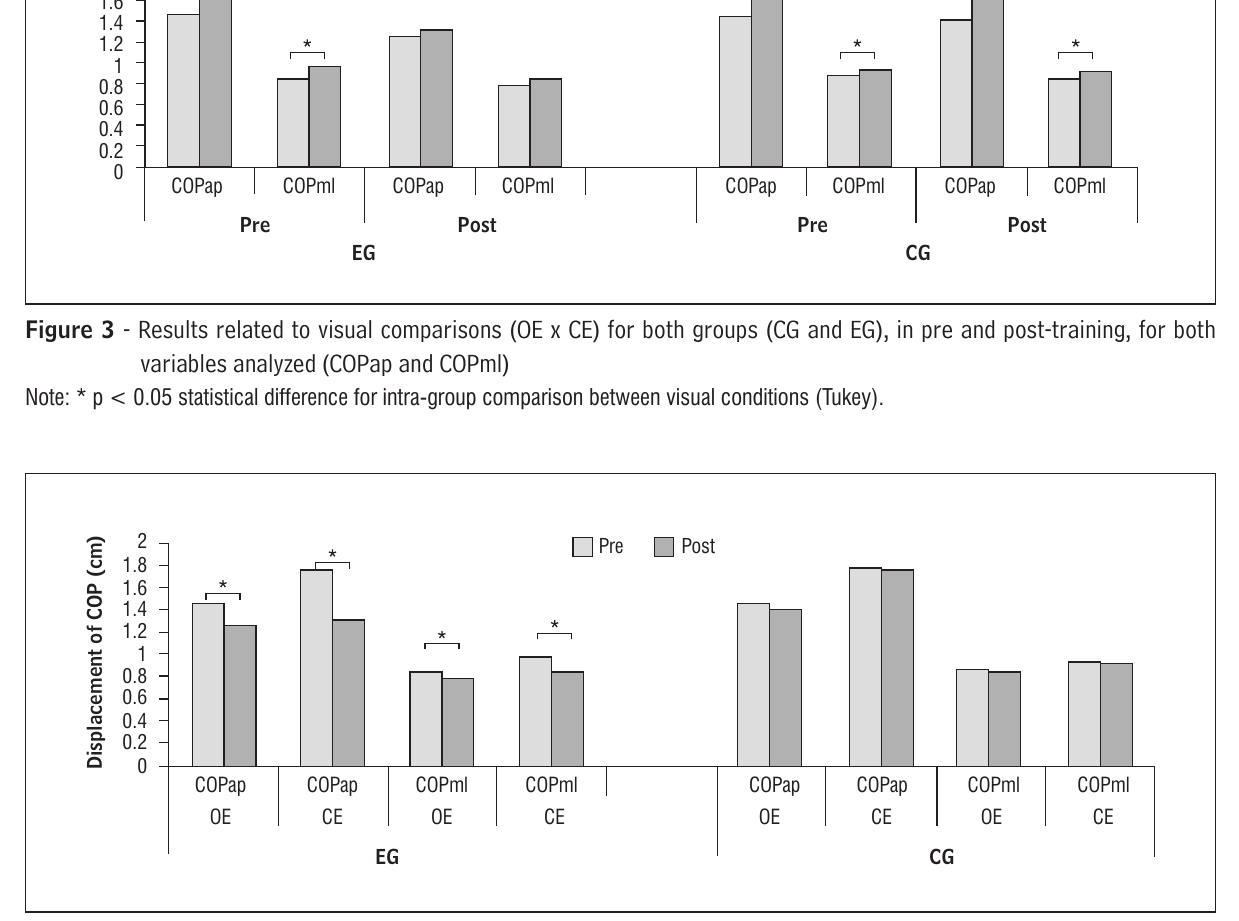
Figure 4 - Results related to intra-group comparisons between pre and post-training, for both variables analyzed (COPap and